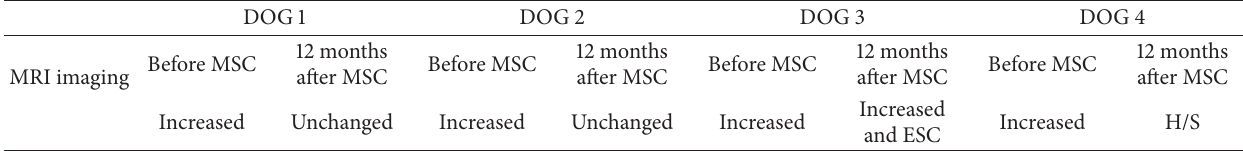
Table 3: Summary results from magnetic resonance